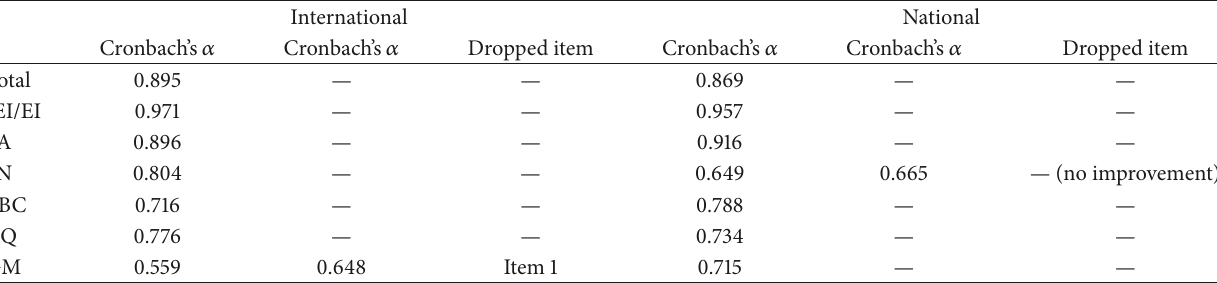
Table 3: Sampling adequacy.